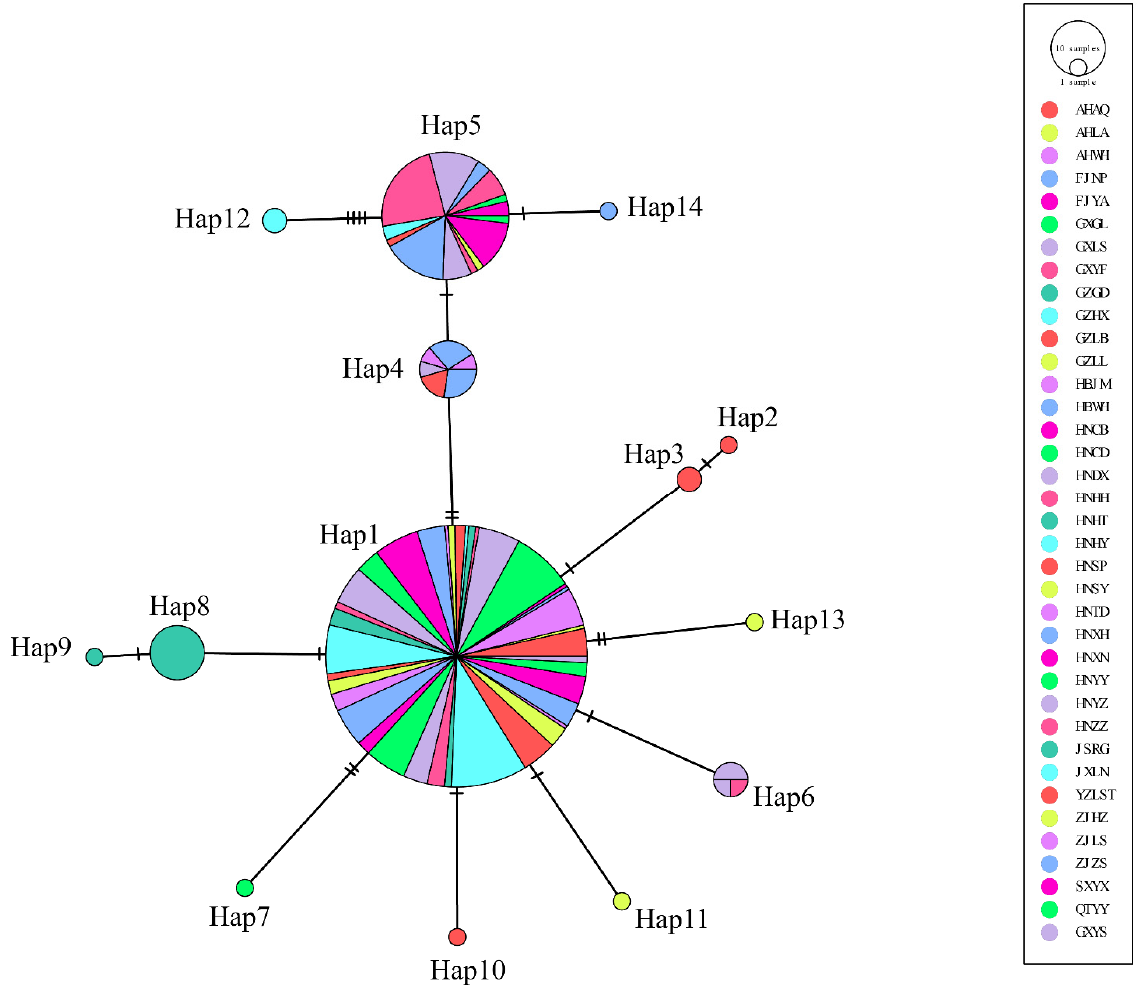
Figure 3. The relationship diagram of the haplotype network of the G. japonicus based on the COI gene. The circles indicate the haplotypes; circle sizes indicate the probability of haplotypes. The different colors in the circles indicate the distribution in different populations, and the oblique lines indicate mutations between haplotypes.